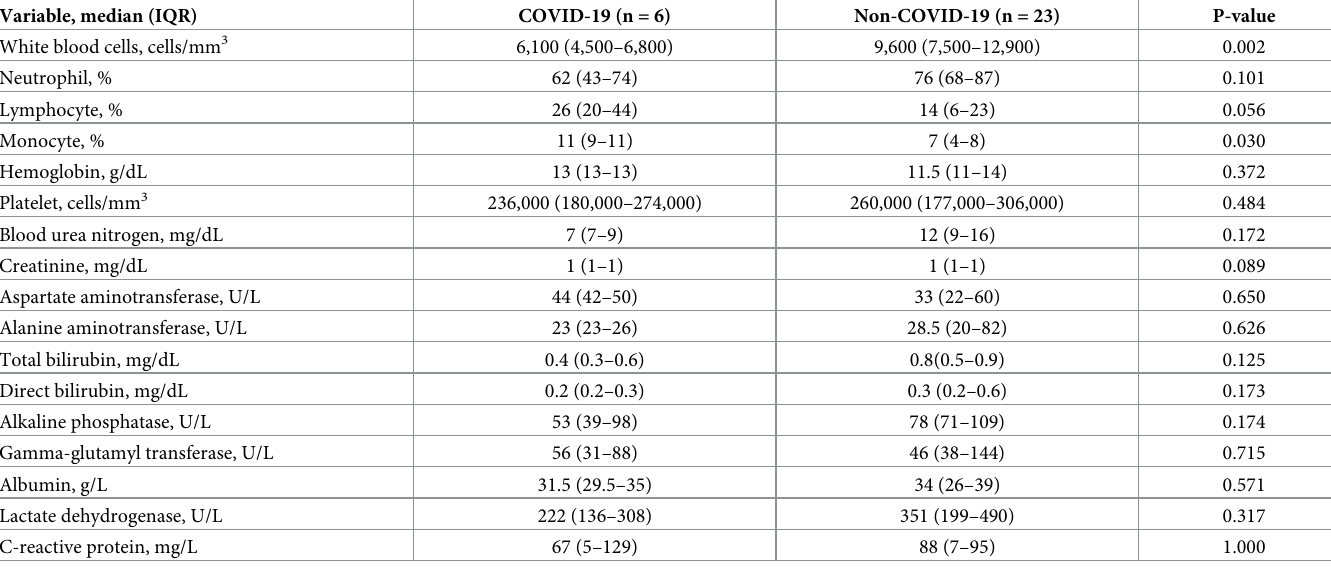
nal symptoms, and headache (P > 0.05, all). Two patients presented with skin rashes; both were in the non-COVID-19 group. Regarding vital signs, those with COVID-19 had signifi- cantly lower median pulse (78 beats/min vs. 98 beats/min; P = 0.008), systolic blood pressure (110 mmHg vs. 133 mmHg; P = 0.008), diastolic blood pressure (64 mmHg vs. 80 mmHg; P = 0.013), and oxygen saturation (96.5% vs. 98%; P = 0.042). Body mass index did not signifi- cantly differ (P > 0.05). The median duration of presenting symptoms did not significantly dif- fer (4 days vs. 3 days; P = 0.288). Only 15% and 21% of COVID-19 and non-COVID-19 patients, respectively, had an abnormal physical exam. An abnormal pharyngeal exam, includ- ing injected pharynx and enlarged tonsils, were reported in 13.2% and 17.6%, respectively (P = 0.426). Abnormal chest examination was seen in 3.8% and 4.3% (P = 1.000), respectively. From the standpoint of laboratory testing results (Table 3), those with COVID-19 presented with significantly lower median white blood cell counts, at 6,100 cells/mm 3 , compared with 9,600 cells/mm 3 in non-COVID-19 patients (P = 0.002). The median percentages of lympho- cytes (25.5% vs. 14%; P = 0.056) and monocytes (10.5% vs. 7%; P = 0.030) were slightly more prominent in COVID-19 patients. Prevalence of lymphopenia and thrombocytopenia did not significantly differ. Levels of liver function tests, lactate dehydrogenase, C-reactive protein, and procalcitonin were indistinguishable between the groups (P > 0.05 for all). Abnormal chest X-ray was more frequently observed in the COVID-19 group, including patchy opacity Table 3. Laboratory results of patients under investigation with and without